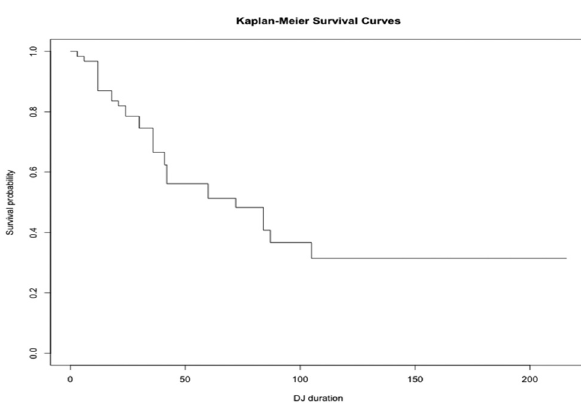
Figure 1: Kaplan – Meier survival curves. The average DJ stenting duration was 54.23 months.